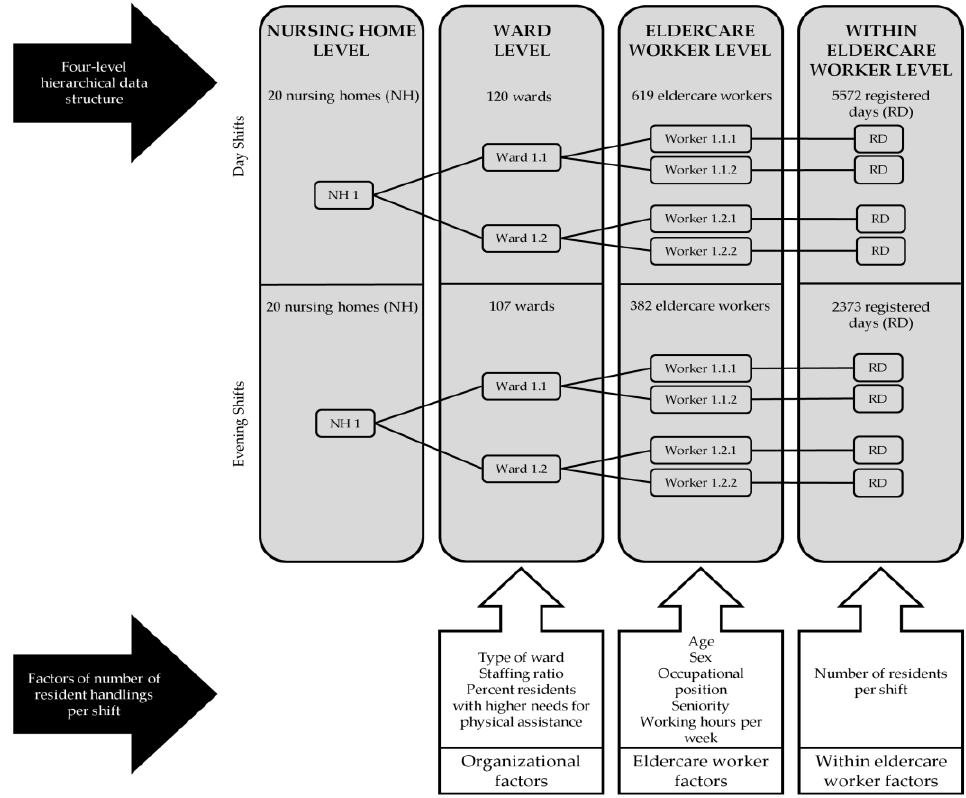
Figure 1. Scheme of the four-level hierarchical data structure of the present study and the level in which the specific investigated factors are measured at. Registered days (RD) (level 4) are clustered within eldercare workers (level 3), eldercare workers are clustered within wards (level 2), and wards are clustered within nursing homes (NH) (level 1), all stratified on day and evening shifts.